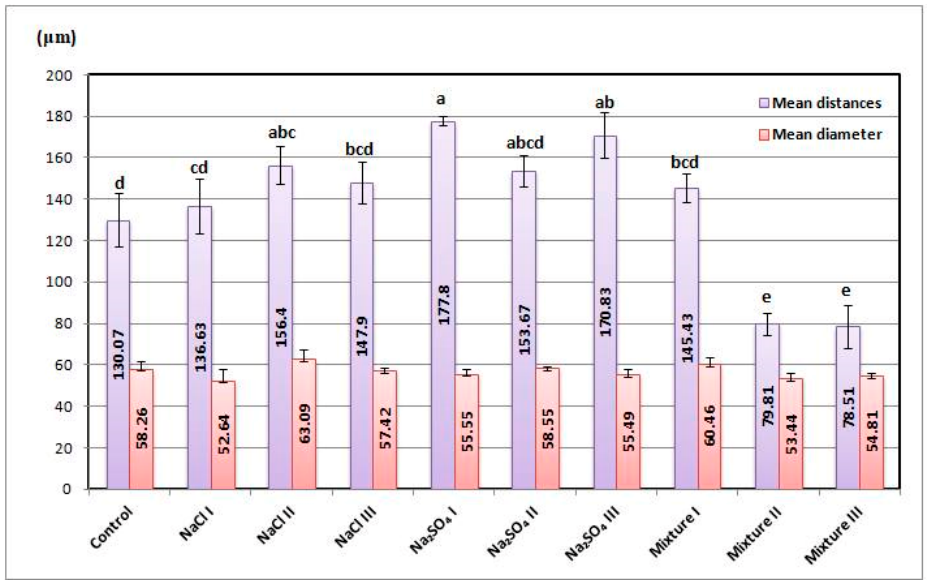
Figure 3. Information related to the granular trichomes: mean diameters and mean distance in between trichomes, respectively, with significant differences at 0.05 level indicated with letters.